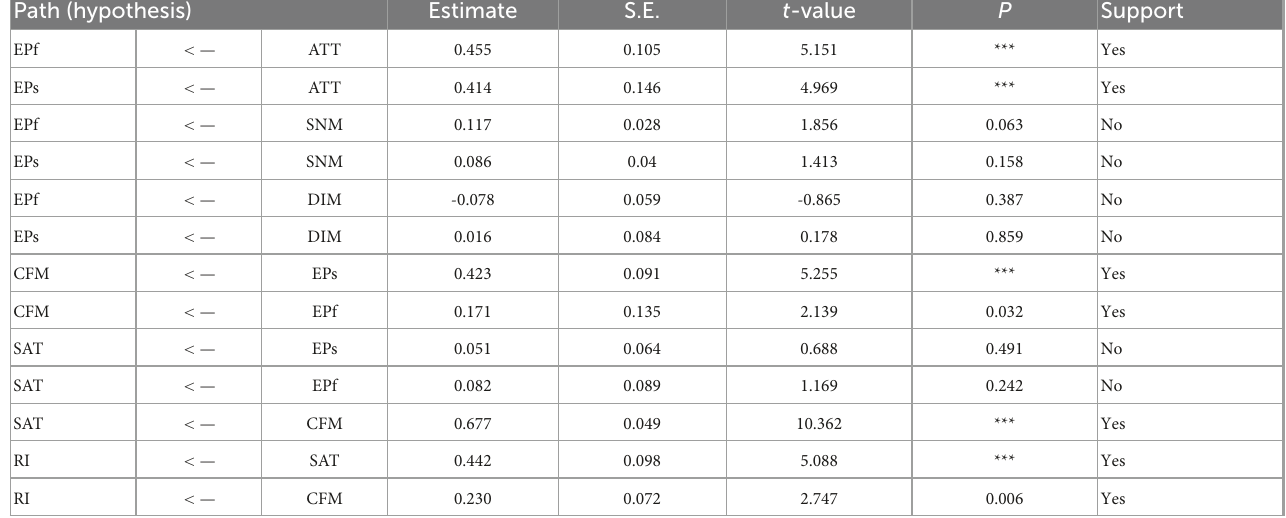
TABLE 6 Path analysis results. Path